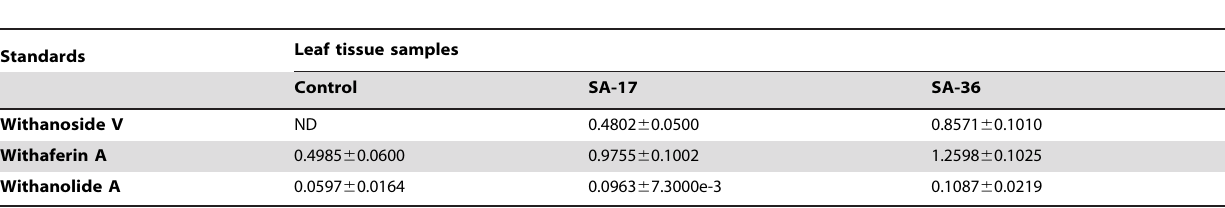
Table 3. Estimation of secondary metabolites in control and salicylic acid treated leaf tissues of W. somnifera .